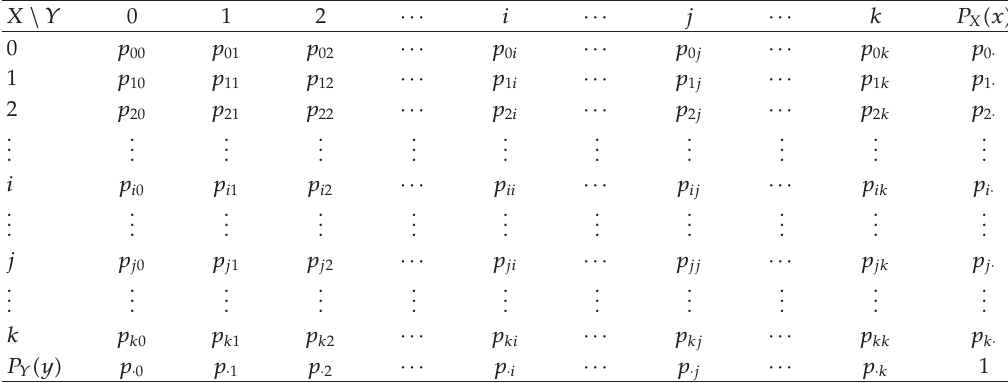
Table 1: The bivariate probability